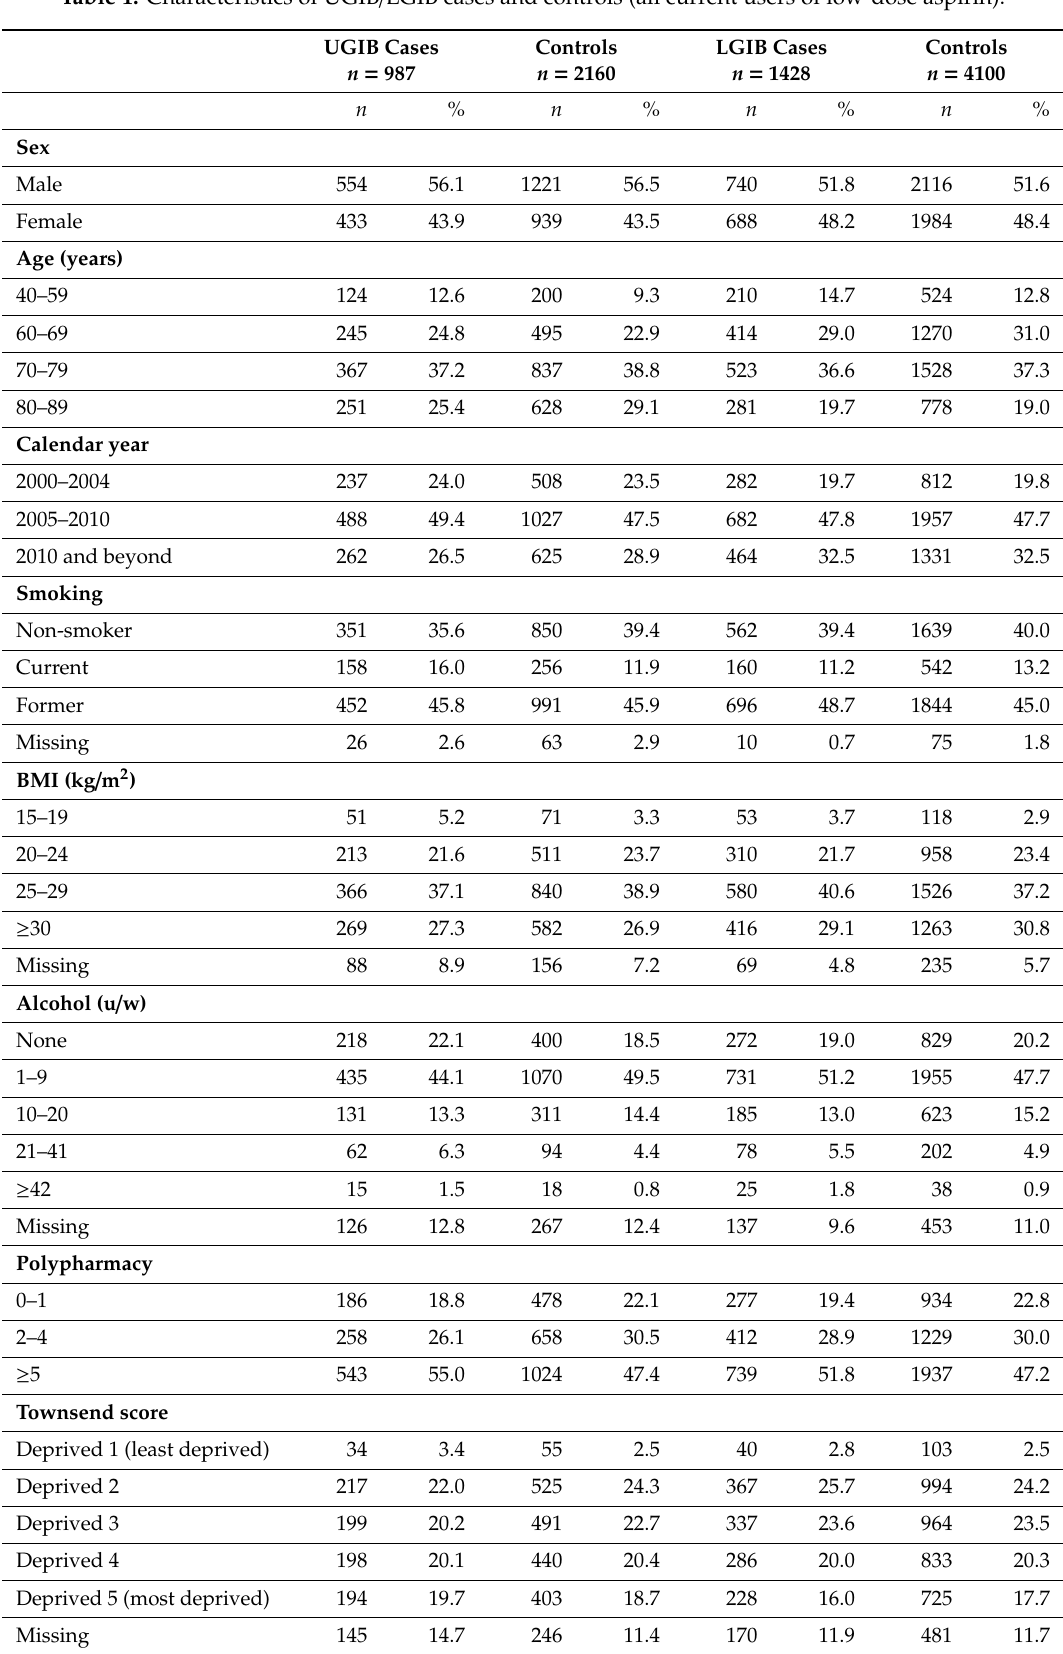
Table 1. Characteristics of UGIB / LGIB cases and controls (all current users of low-dose